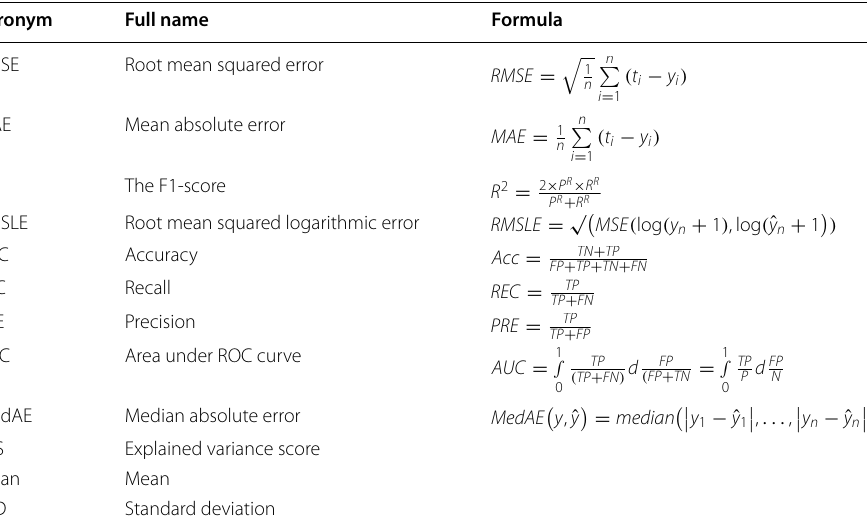
Table 3 Used evaluation metrics